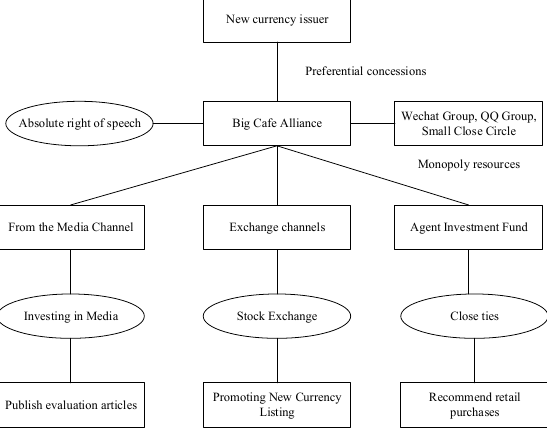
ff ering (ICO) in